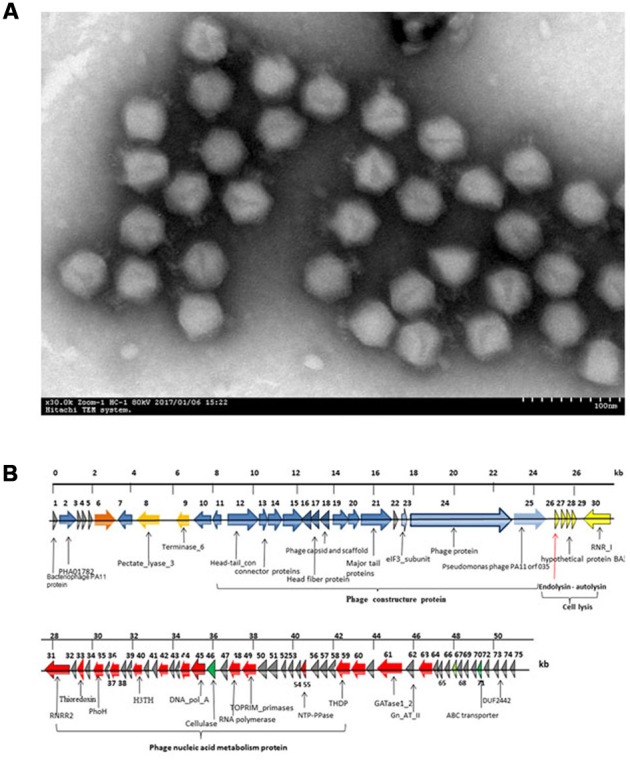
Characterization of bacteriophage JD010. (A) Scanning electron microscopy image of phage JD010, negatively stained with 0.2% phosphotungstic acid. The scale bar represents 100 nm. (B) Genome organization map of phage JD010. The arrows in the figure indicate the predicted ORF of the phage genome. The red arrow points to the endolysin gene.